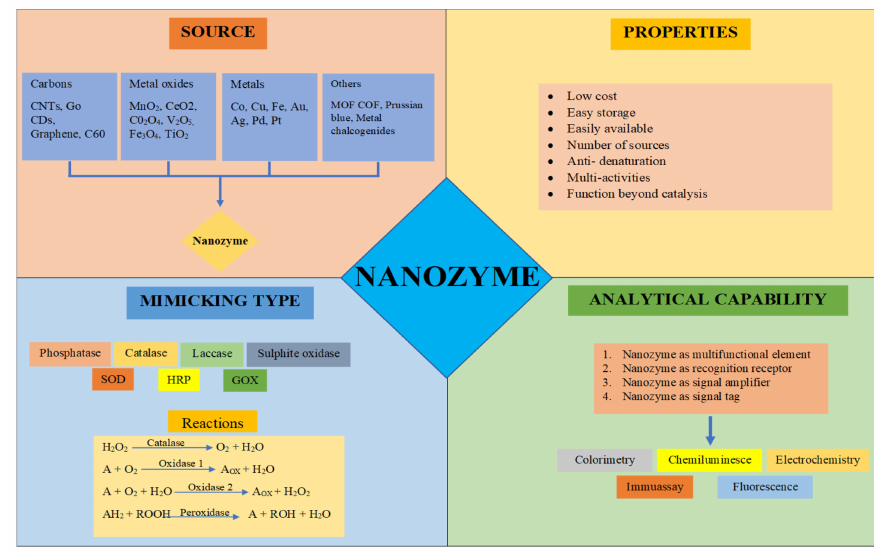
Figure 1. Sources, properties, mimicking types, and analytical capabilities of